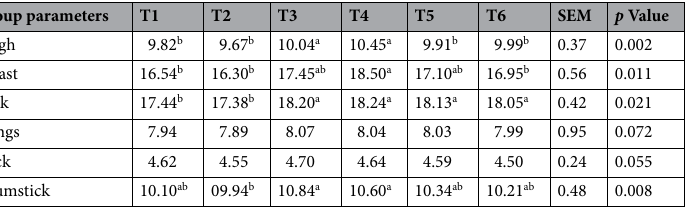
Table 2. Effects of dietary inclusion of prebiotics on cut up parts (% of live weight) in broiler chickens. T1 (no MOS/FOS/BMD), T2 (0.002% BMD), T3 (T1 + 0.1% MOS), T4 (T1 + 0.2% MOS), T5 (T1 + 0.1% FOS), T6 (T1 + 0.2% FOS). SEM = Standard error of mean; NS = Non-significant; n = 15. Mean values bearing the same superscript in a row did not differ significantly ( p <